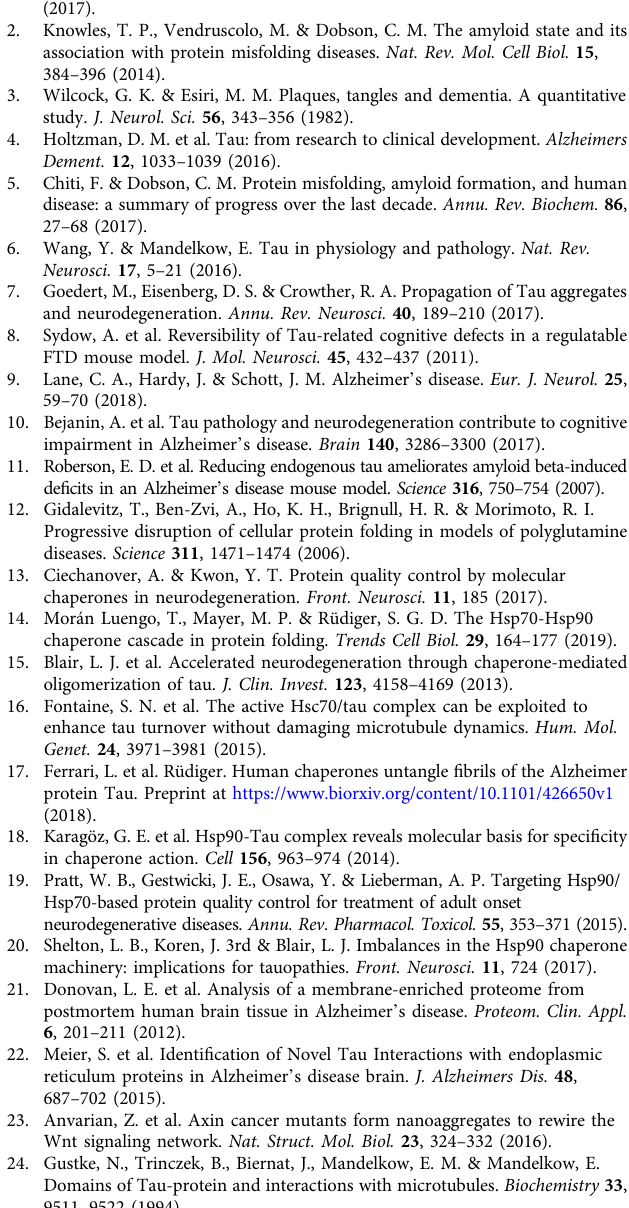
Figure 2b: Quanti fi cations of proteins detected at t = 0, 1, 8 and 24 h in replica 3 are represented in the heat map. Figure 2c: Heat map shows an unbiased selection of proteins co-precipitating with Tau-RD* monomers without heparin ( t 0 − ) compared to control pull downs (empty FLAG-beads). Only proteins with a Fold Change calculation >3 (FC-B, Crapome; by averaging the spectral counts across the selected controls) were considered enriched in Tau-RD* monomers without heparin ( t 0 − ) compared to controls in the three different biological replicas. Values shown in the heat map refer to time points t 0 , t 1 , t 8 , and t 24 of replica 3. Supplementary Fig. 2: Interactors of Tau-RD* monomers selected in Fig. 2c are shown with their relative quanti fi cations across all time points in three biological replicas. Figure 2d Heat map shows an unbiased selection of proteins speci fi cally co-precipitating with Tau-RD* aggregates ( t 4 ) compared to Tau-RD* monomers without heparin ( t 0 − ). Only proteins with a Fold Change calculation> 2 (FC-B, Crapome; by averaging the spectral counts across the selected controls) were considered enriched in Tau-RD* aggregates ( t 4 ) compared to Tau-RD* monomers in the three different biological replicas. Values shown in the heat map refer to time points t 0 , t 1 , t 8 , and t 24 of replica 3. Supplementary Fig. 3: Full list of interactors of Tau-RD* oligomers and fi brils ( t 4 ) shown in Fig. 2d is shown with their relative quanti fi cations across all time points in three biological replicas. Figure 6b: Bar graph shows same selected proteins of Supplementary Fig. 3 (signi fi cant proteins interacting with Tau-RD* aggregates t 4 ) and their average quanti fi cations in Tau- RD* ( t 4 ) compared to Tau-RD* + Hsp90 ( t 4 ) across three different biological replicas. Ratios of normalized PSMs of interactors in Tau-RD* + Hsp90/ normalized PSMs of interactors in Tau-RD* − Hsp90 are graphically represented and shown as percentages. Negative values indicate a decreased binding af fi nity in presence of Hsp90, while positive ones indicate a higher af fi nity. Quanti fi cation of selected interactors of Tau-RD* monomers without heparin t 0 − (Fbxo3, Poldip2, Ctbp1, Ctbp2) is also included as additional control. Most of the interactors of Tau- RD* aggregates reduce their binding af fi nity in presence of Hsp90, whereas Fbxo3, Poldip2, Ctbp1, and Ctbp2 do not. The full datasets are available in Supplementary Data 1 and 3.